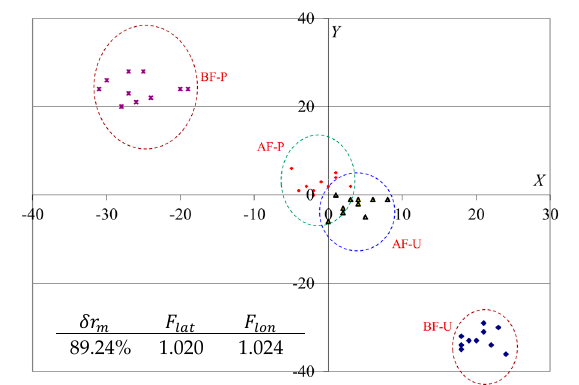
Figure 4. Radial systematic error of (left) jumper robot before and after calibration. BF and AF shows the locations of the robot stop point before and after calibration, respectively. The improvement measures are also shown in the